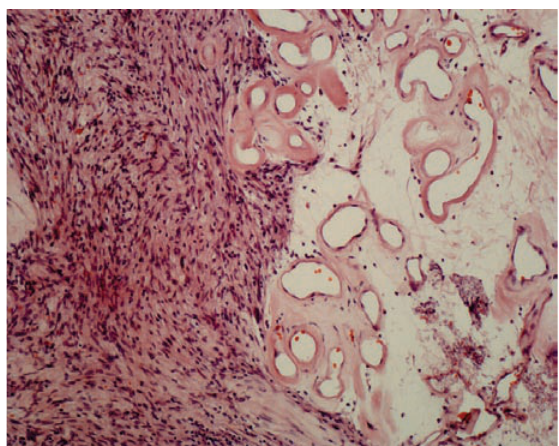
Figure 4. Schwann cells arranged in hypercellular (Antoni A) and hypocellular (Antoni B)